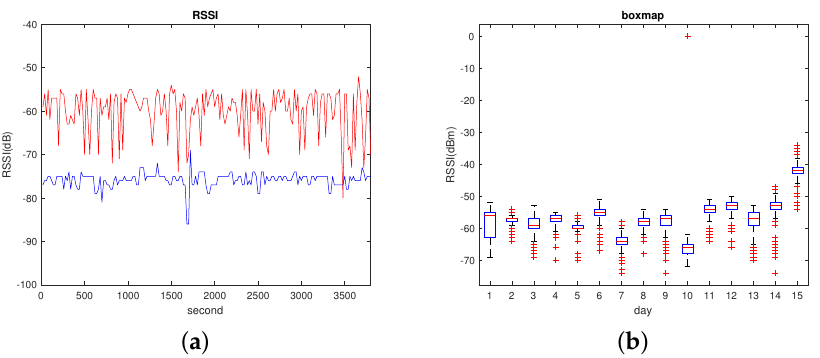
Figure 2. Received-signal-strength-indicator (RSSI) changes. ( a ) Changes of the RSSI of two Access Points (APs) in a short period; ( b ) box-diagram description of RSSI AP changes in 15 days.